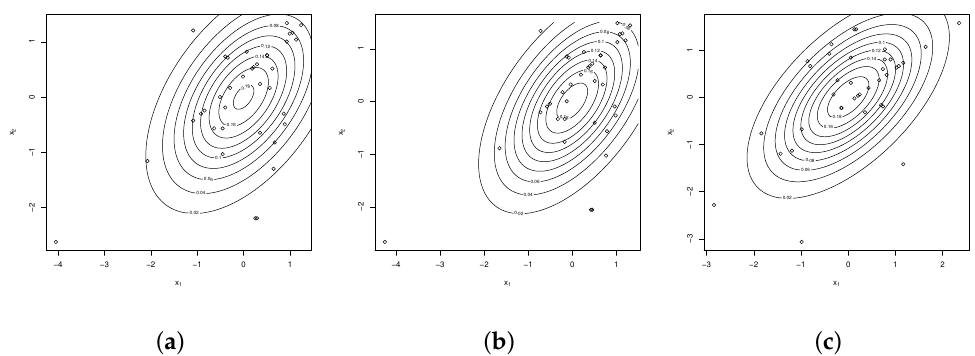
Figure 3. Contour plots of bivariate distributions: ( a ) BVLN, ( b ) BVBS, and ( c ) BVUBS.